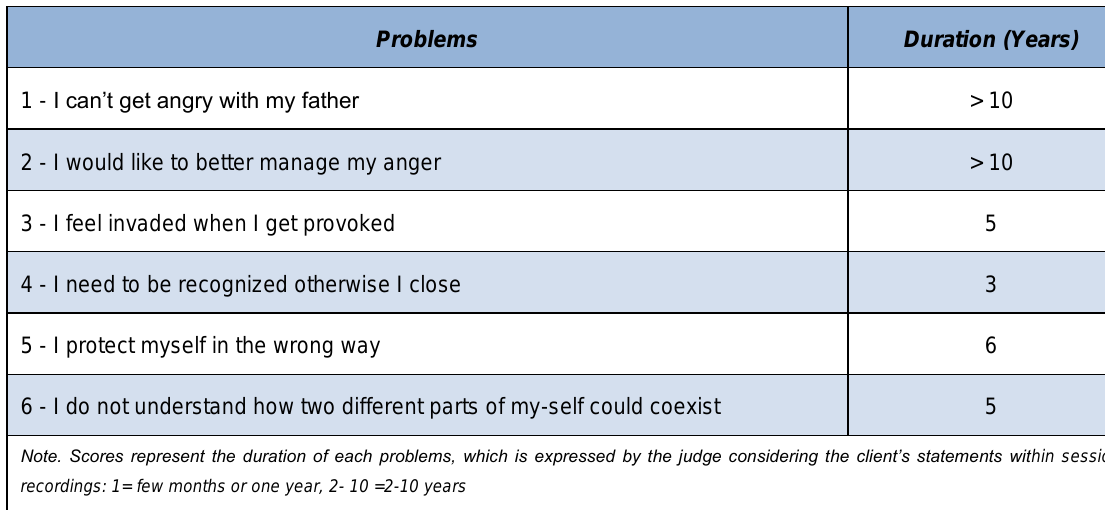
Table 5: Duration of problems